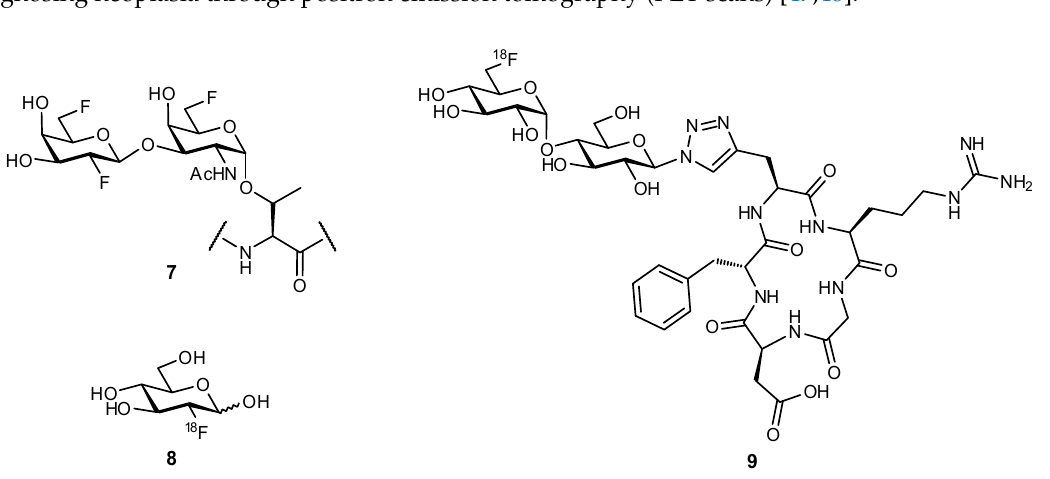
Figure 3. The bioisosteric replacement of hydroxy substituents with one or more fluorine atoms has proven successful in generating glycomimetics [46,48] .